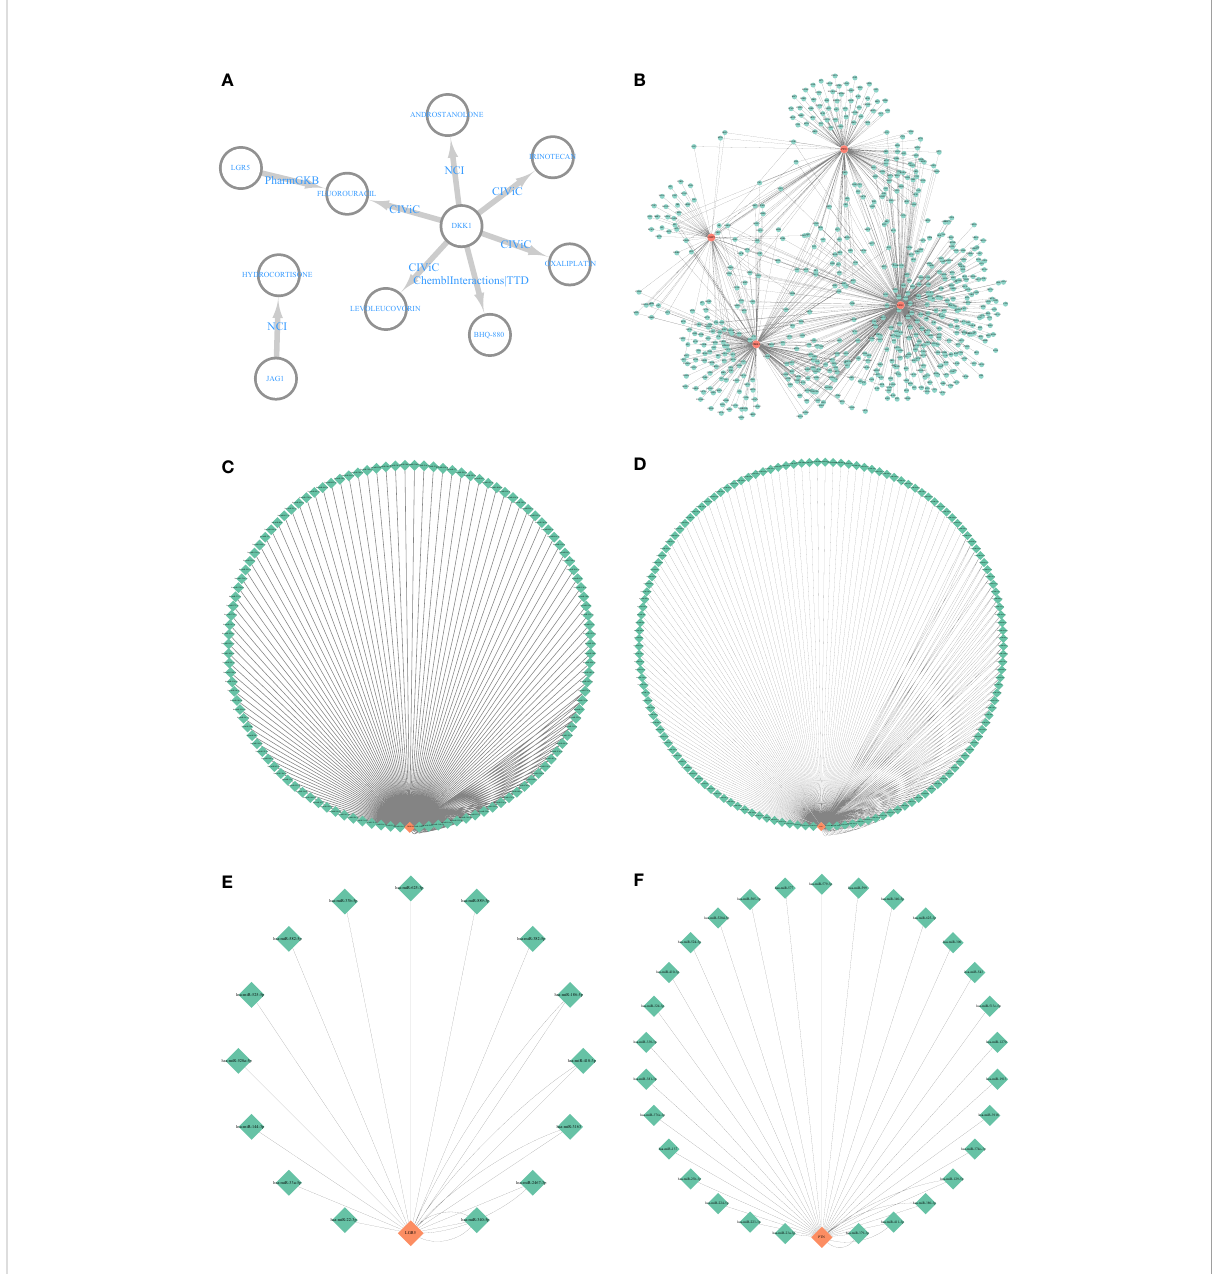
FIGURE 9 Interactive network analysis. (A) Differentially expressed immune-related gene (DEIG) – drug network; (B) DEIG – transcription factor network. (C) DKK1 – miRNA network. (D) JAG1 – miRNA network. (E) LGR5 – miRNA network. (F) PTN – miRNA